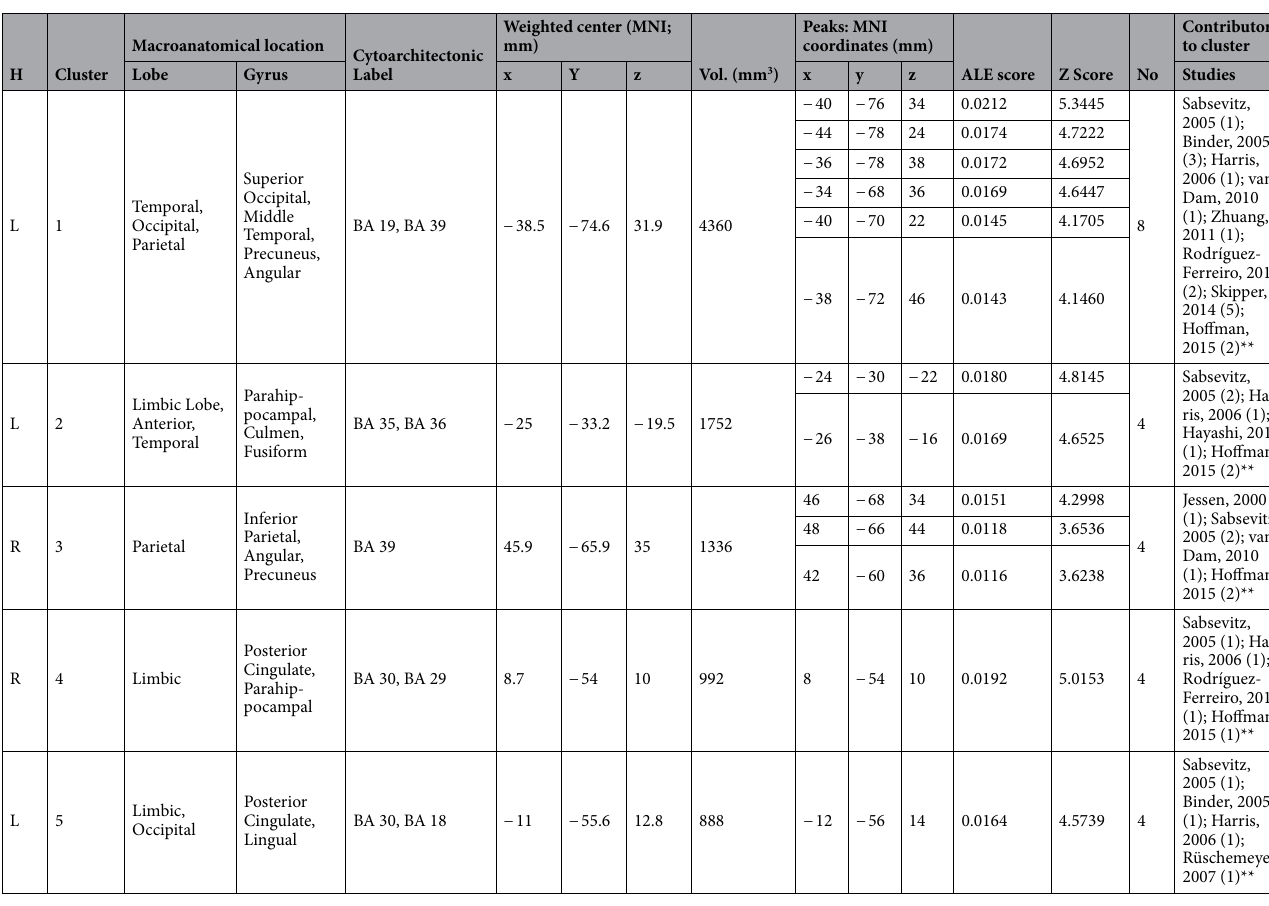
Table 4. Concrete > abstract words—visual stimuli- clusters. Included 121 stereotactic activation loci from 18 studies, 301 participants, chosen min. cluster size 616 mm 3 . All the values and labels were extracted from the GingerALE output files. Clusters are ordered for decreasing volume size. Coordinates (x, y, z) are in the MNI space. H = Hemisphere; ALE = activation likelihood estimation; Nr. = number of studies that contributed